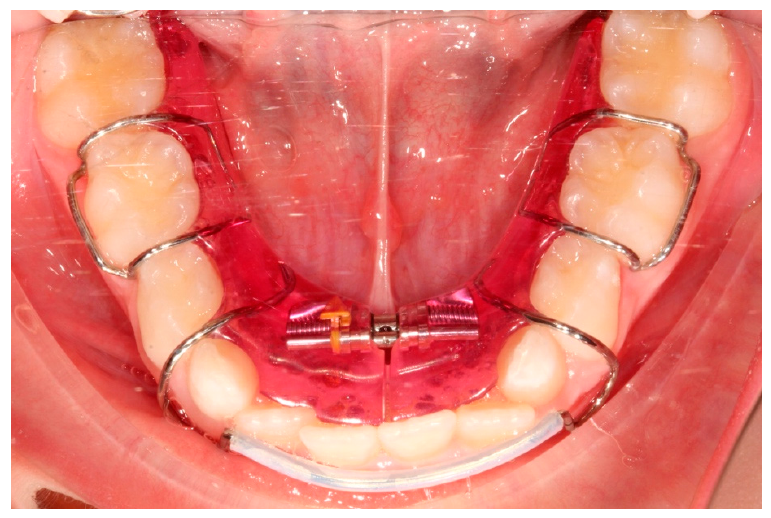
Figure 2. Schwarz Figure 2. Schwarz appliance. Figure 2. Schwarz appliance.